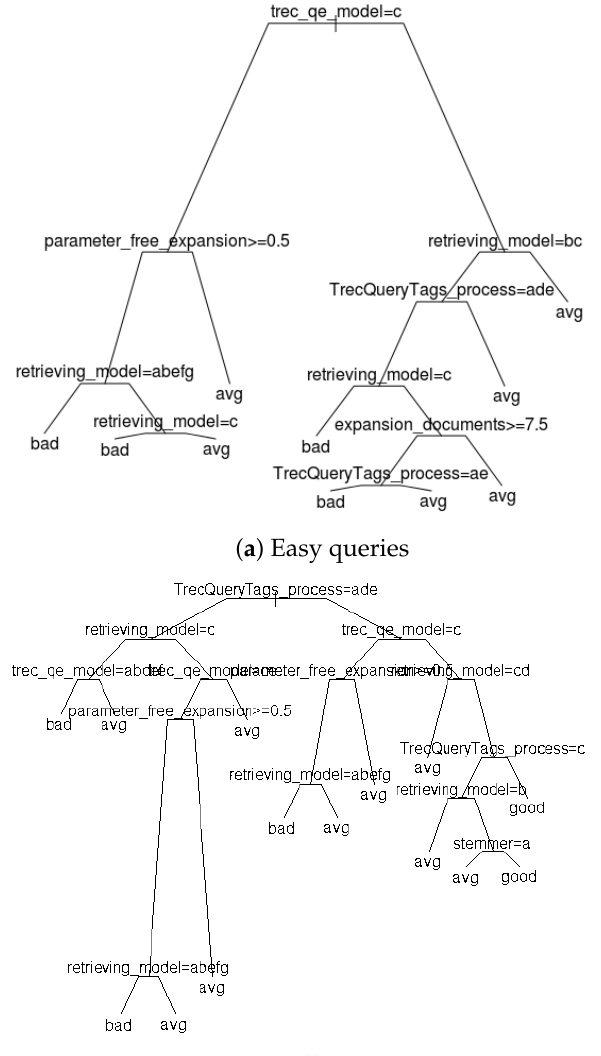
Figure 17. The parameters that affect retrieval effectiveness the most depend on the query difficulty. On ( a ), for easy queries, the most important parameter for search effectiveness optimisation is the choice of the query expansion component; on ( b ), for hard queries, the most important parameter is the topic parts used for building the query, then the weighting component and in third the query expansion model. Figure reprinted with permission from [7], Copyright 2015,